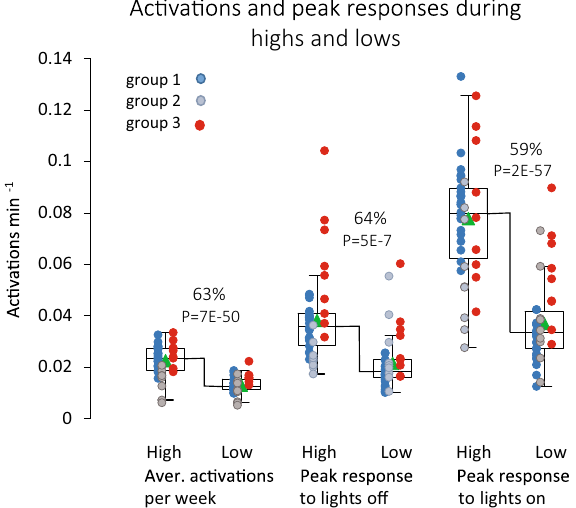
Figure 5. Boxplots of weekly average activations during weeks of highs and lows, respectively, followed by peak response in activations (above weekly average) in the responses to lights-off (middle) and lights-on (right) for the three groups of cages during weeks of highs and lows, respectively. Cages belonging to the different groups (Material and Methods) have been indicated with different colors; blue is group 1, grey is group 2 and red is group 3.